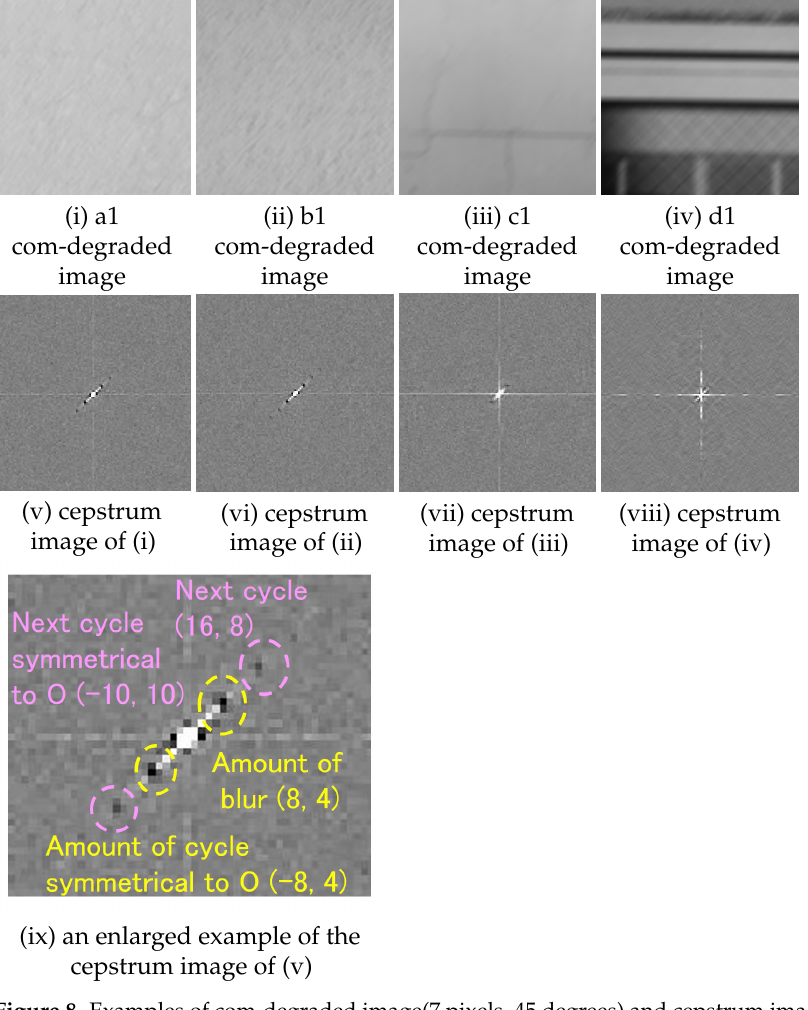
Figure 8. Examples of com-degraded image(7 pixels, 45 degrees) and cepstrum image from area A to D (121 × 121 pixels). Table 7. The blur amount (5 pixels, 0 degrees and 90